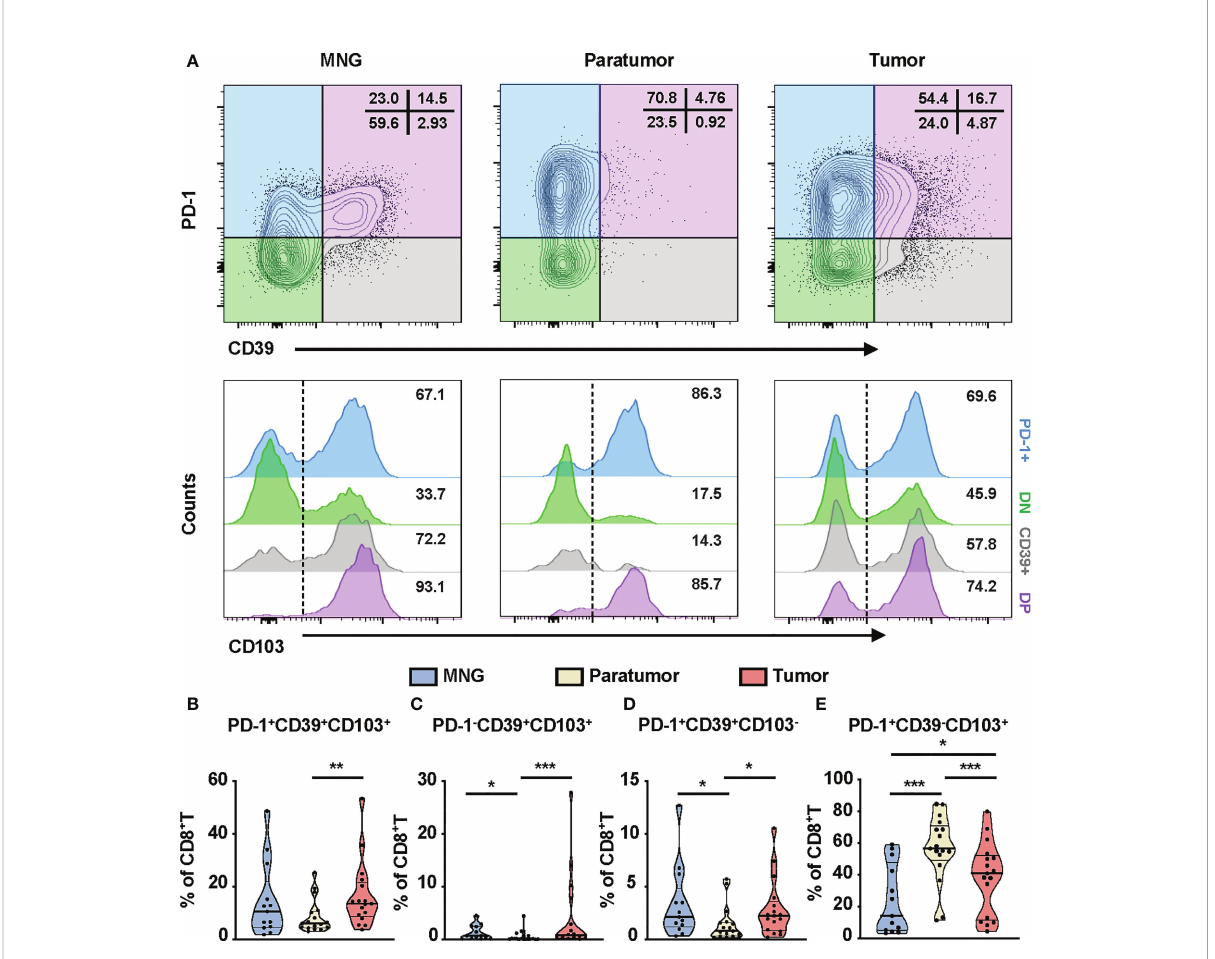
FIGURE 3 Phenotypic characteristics of CD8 + T cells in thyroid tissues from MNG and PTC patients. (A) Flow cytometric analysis PD-1 and CD39 expression on CD8 + T cells from thyroid tissues of MNG and PTC patients. Numbers in each quadrant indicate percent cells positive for PD-1 and/or CD39 on CD8 + T cells. Below, histograms show the CD103 expression on PD-1 + CD39 - (PD-1 + , blue), PD-1 - CD39 - (DN, green), PD-1 - CD39 + (CD39 + , gray), and PD-1 + CD39 + (DP, purple) cells. Frequencies of PD-1 + CD39 + CD103 + CD8 + T (B) , PD-1 - CD39 + CD103 + CD8 + T (C) , PD- 1 + CD39 + CD103 - CD8 + T (D) , and PD-1 + CD39 - CD103 + CD8 + T (E) cells in thyroid tissues of MNG and PTC patients. Data presented as mean ± SEM. *p < 0.05; **p < 0.01; ***p <